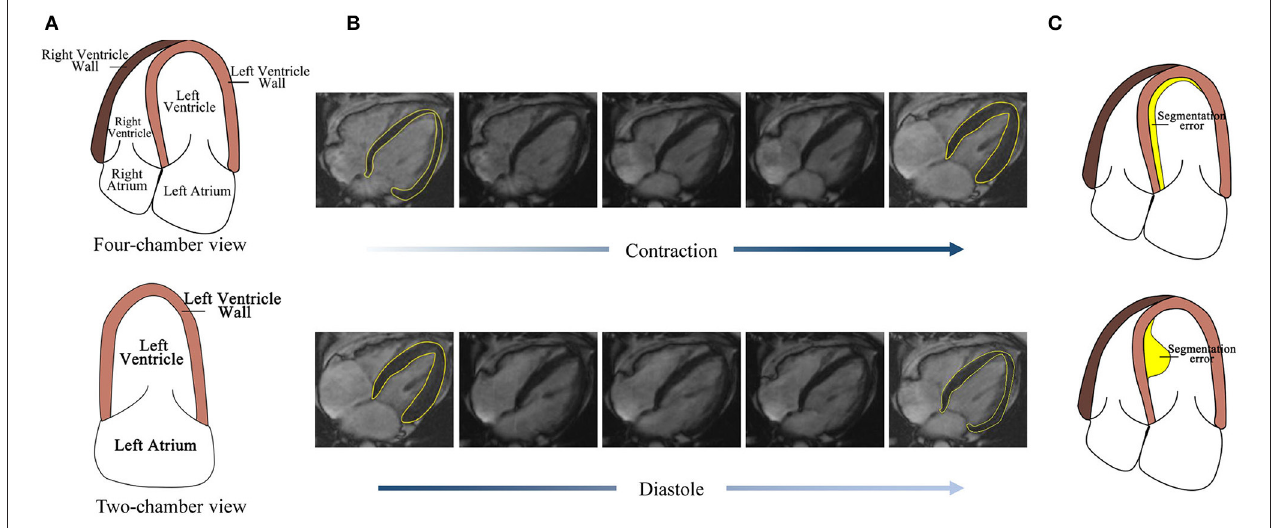
FIGURE 1 | Challenges for four-chamber view MRI image segmentation. (A) The structure of the four-chamber view cardiac image is more complex than that of the two-chamber view. (B) The LV wall difference between frames caused by cardiac motion is small, thus high accuracy is needed. (C) Detection error with the same area but the different effect to its subsequent